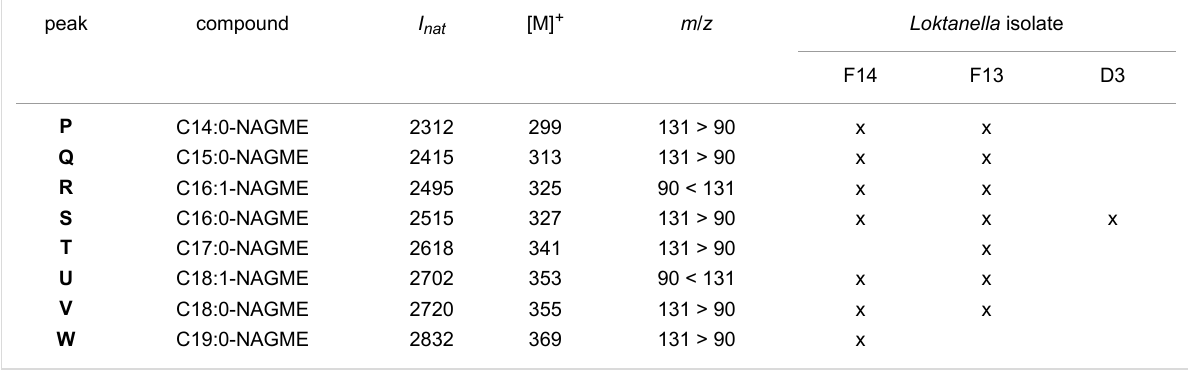
Table 2: NAGMEs produced by Loktanella related isolates F14, F13 and D3. I nat : gas chromatographic retention index on a HP-5 phase; [M] + : molecular mass; m / z : characteristic ions in EI mass spectra. peak